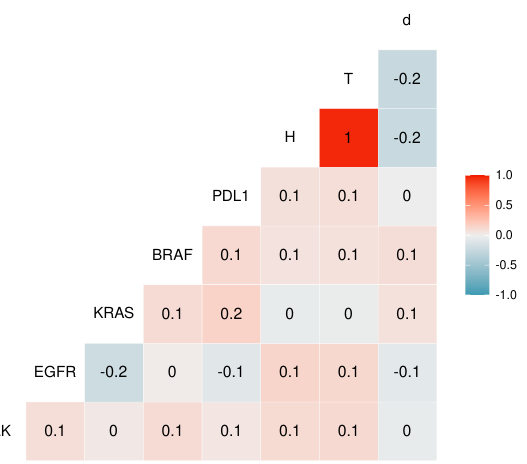
Figure 4. Pearson correlations between the biomarker status ALK, BRAF, EGFR, KRAS, PDL1, cumulative death hazard H, survival time T, and death status in the Flatiron NSCLC